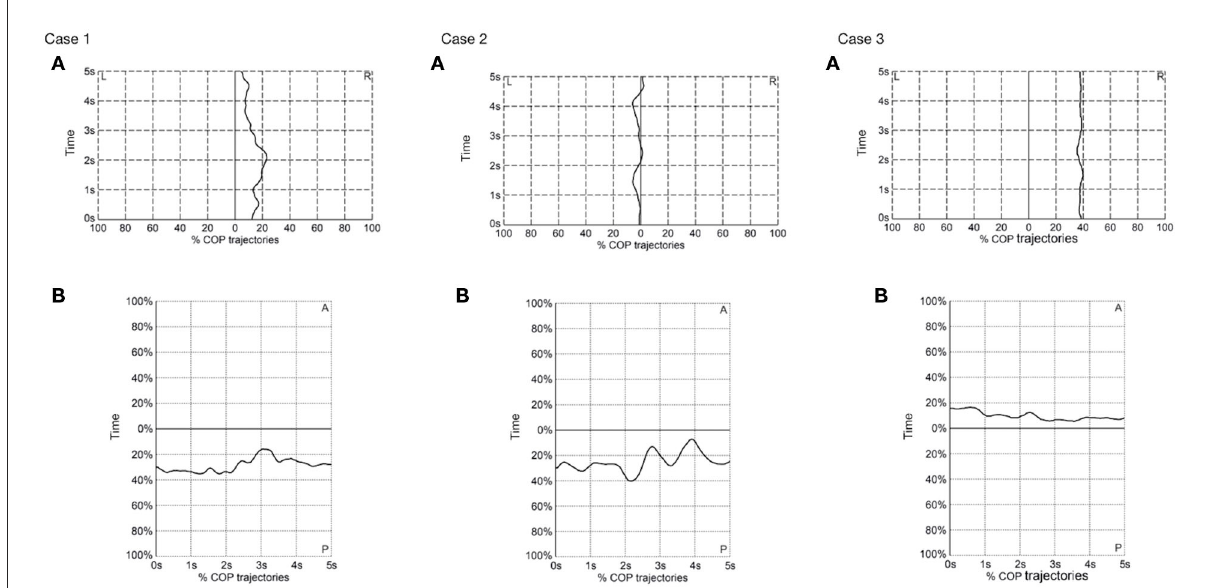
FIGURE3 Center of pressure trajectories in (A) mediolateral (ML) and (B) anteroposterior (AP) axes in the three cases in the static standing position. L, left; R, right; COP, center of